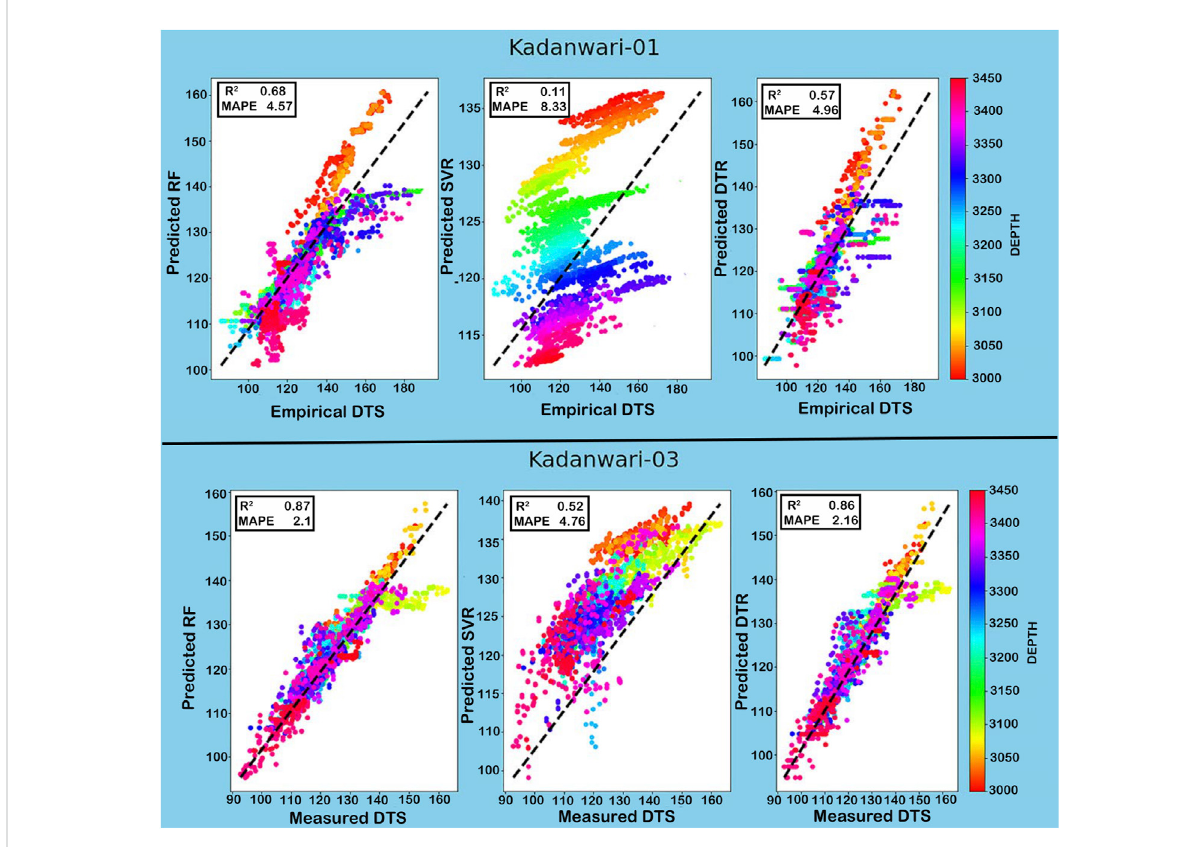
FIGURE 6 Cross plot between empirically derived and predicted DTS curve in the Kadanwari-01 well and between measured and predicted DTS curve in Kadanwari-03 depicting RF as the best